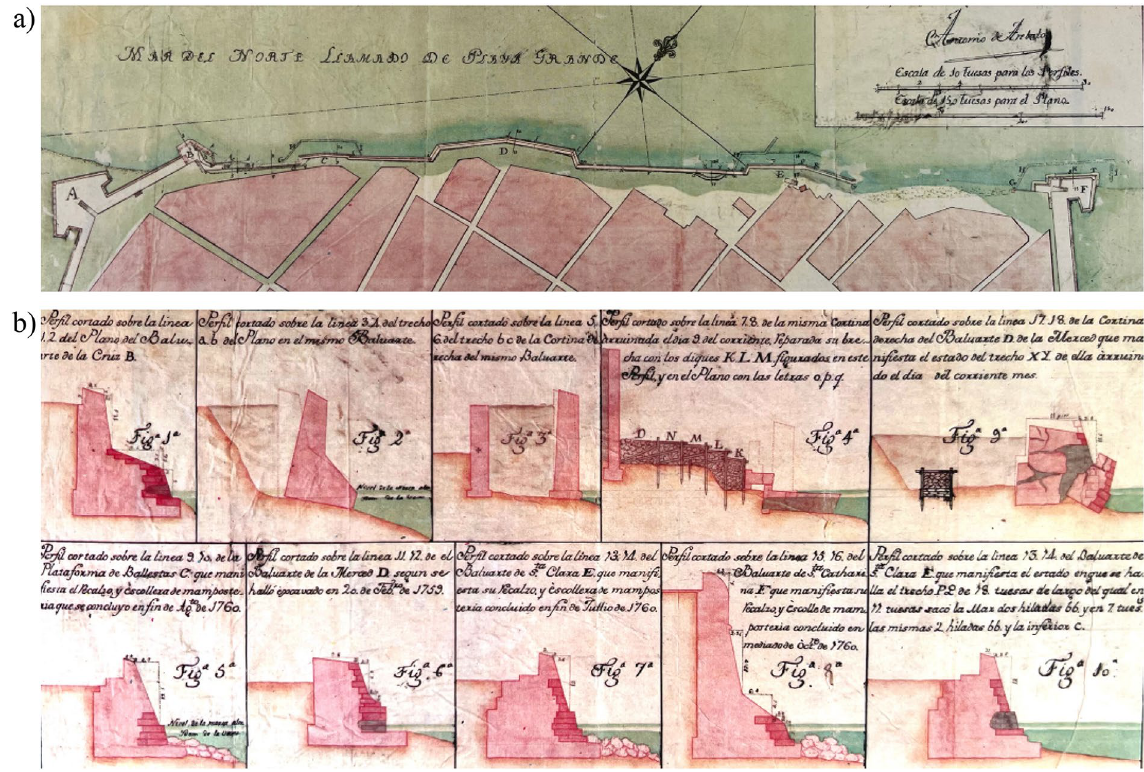
Fig. 6 Original drawings of Antonio de Arévalo from 1761. Taken and adapted form (Zapatero Lopez and García Baquero 1980). Observe in green the flooded areas of the historic center of Cartagena that destroyed parts of the walls. a Partial plan of the historic center and flooded areas in green; b Ten different profiles of the walls damaged are reported and descripted. For more details about the text in the figures look at the descriptive folder of the Military historical service of Spain, (Zapatero Lopez and García Baquero